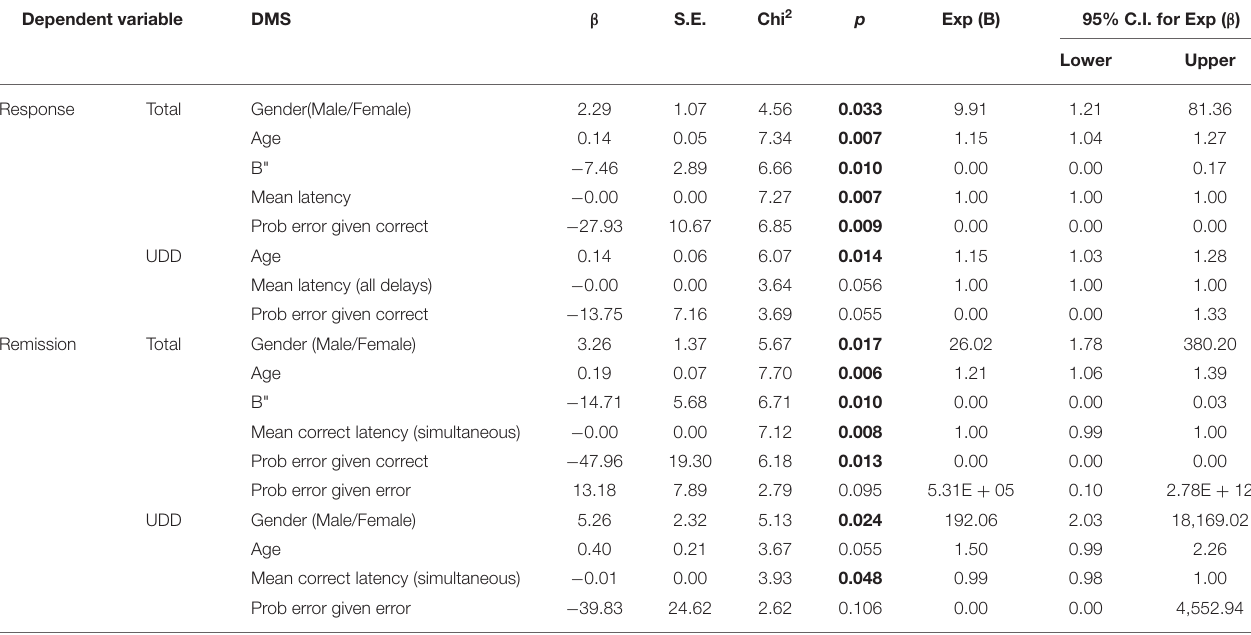
TABLE 5 | Binary logistic regression analysis: demographic and DMS predictors of response or remission. Dependent variable